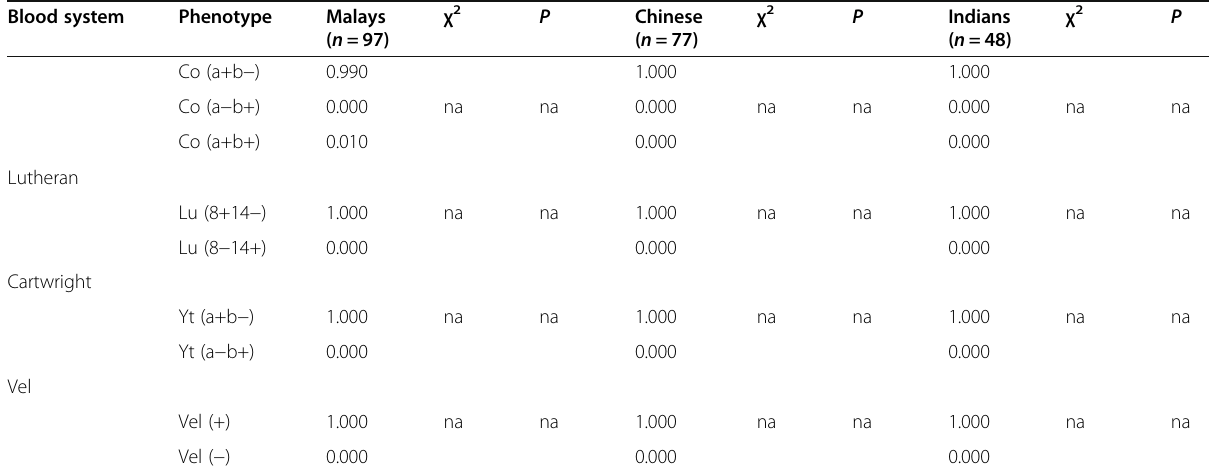
Table 1 Phenotype frequencies and HWE analysis of blood group systems in Malays, Chinese, and Indians (Continued) Blood system